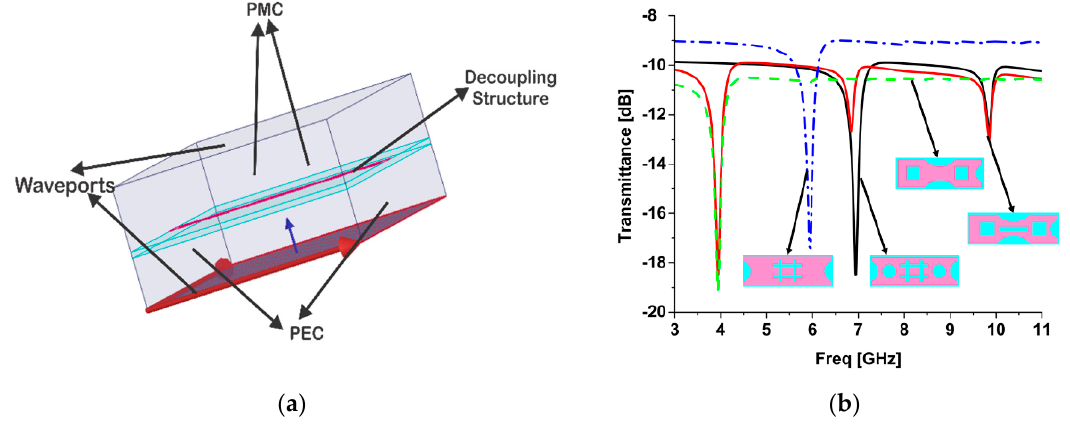
Figure 4. Analysis. ( a ) Analysis setup; ( b ) transmission loss.